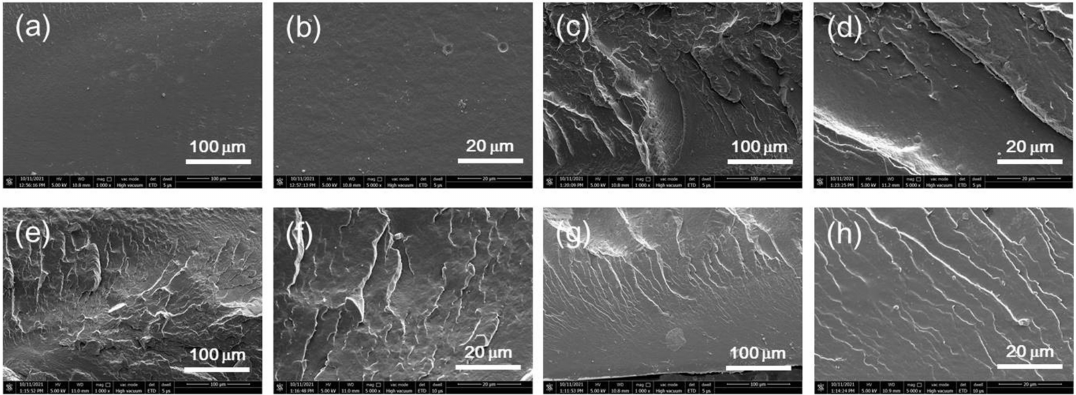
Figure 1. SEM images of the cross-section PBAT/Ti 3 C 2 T X nanocomposite films. ( a , b ) PBAT-0, ( c , d ) PBAT-0.5, ( e , f ) PBAT-1.0, and ( g , h )